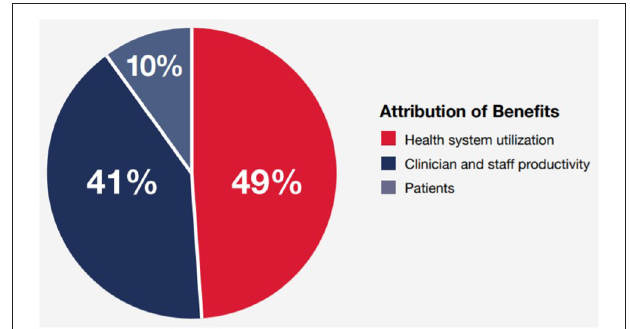
FIGURE 1 | Portion of Digital Health benefits flowing to patients, clinicians and health systems in 2019. Infoway Annual Report 2018–2019. Sourced from Digital Health outcomes models developed between 2008 and 2021 to estimate impacts in Canada